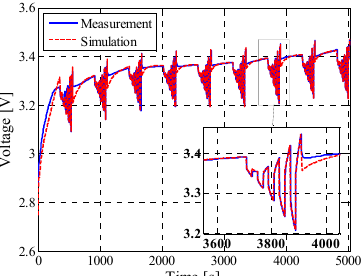
Figure 23. Measured and estimated voltage profiles during dynamic pulse charging and discharging of the LFP/C battery ( I bat = 2.5 A, T = 25 °C). Figure 24. Distribution of the relative error obtained during dynamic pulse charging and discharging verification case.